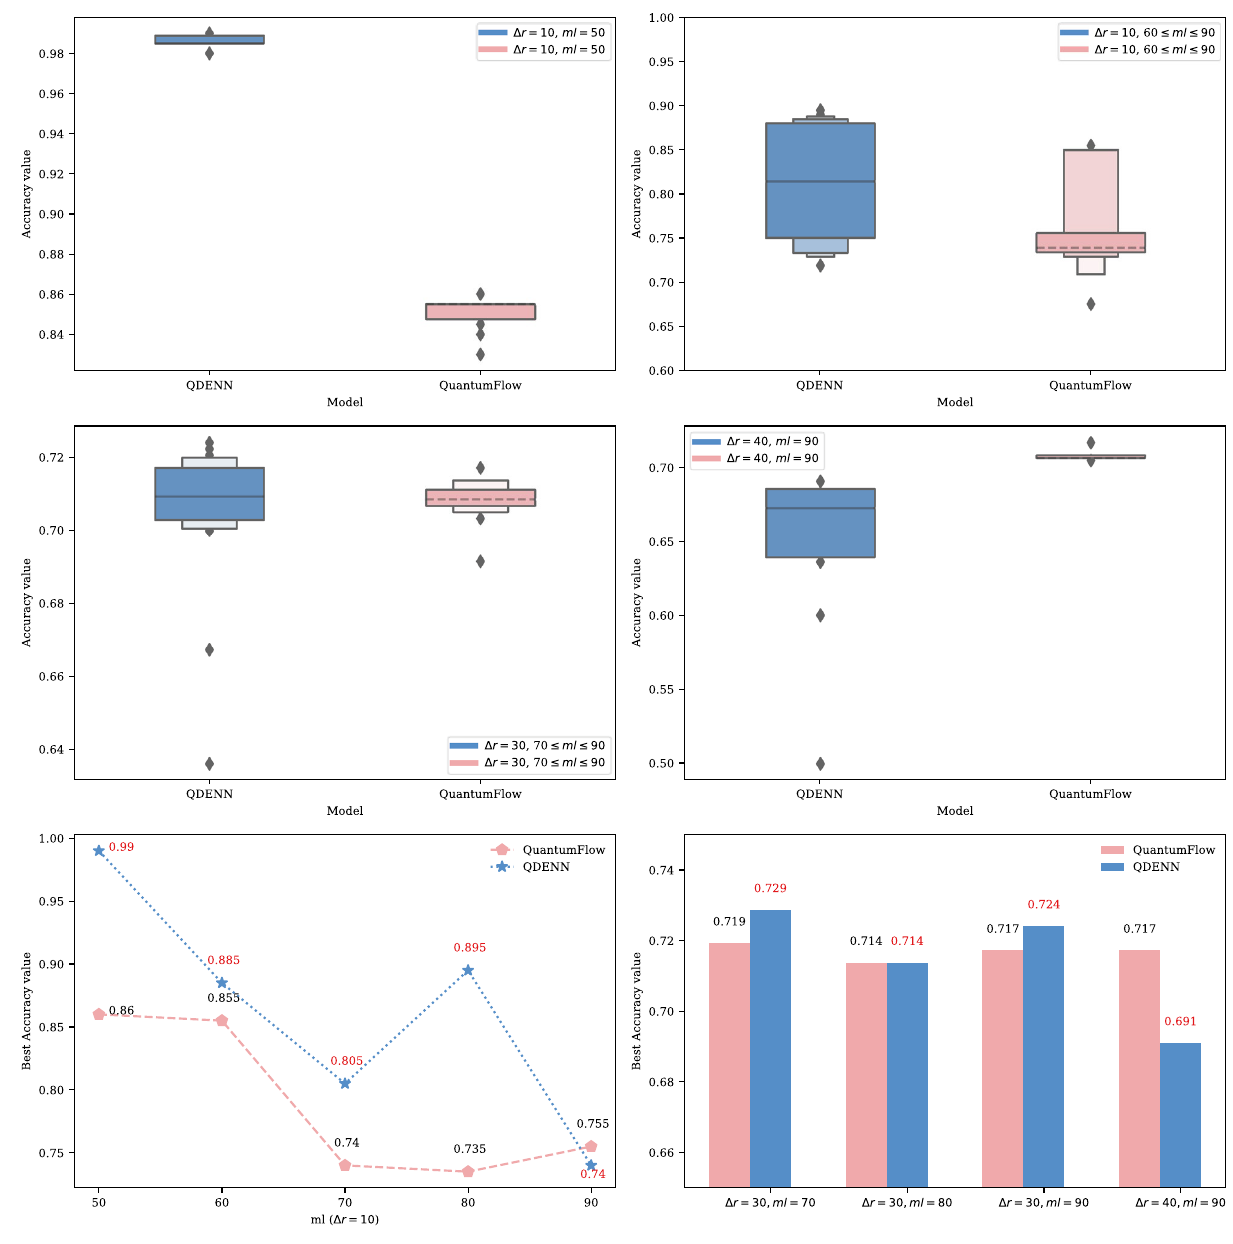
Figure 5. Validation accuracy value distribution during training. Here, the box plots reveal the distribution of accuracy values using different quantum neural networks during training. Meanwhile, the line chart and the histogram reveal the best accuracy comparison of the QDENN and QuantumFlow, which was chosen as the baseline in this